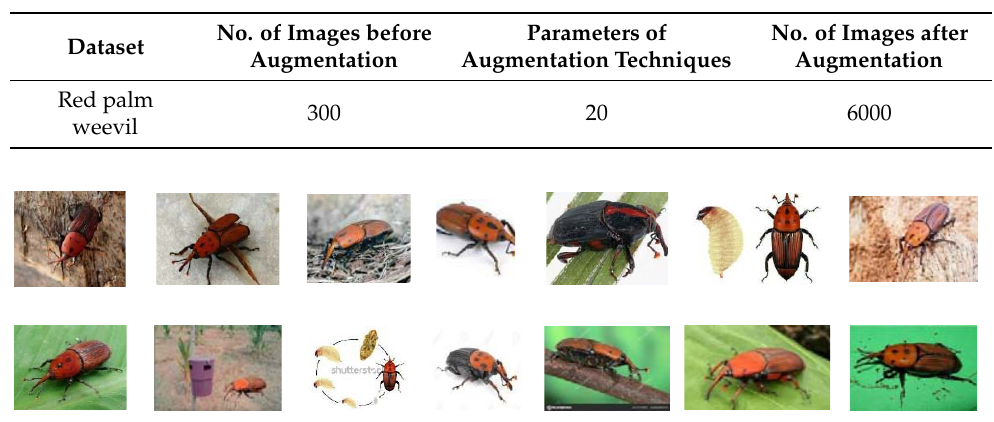
Table 2. Statistics of red palm weevil dataset.